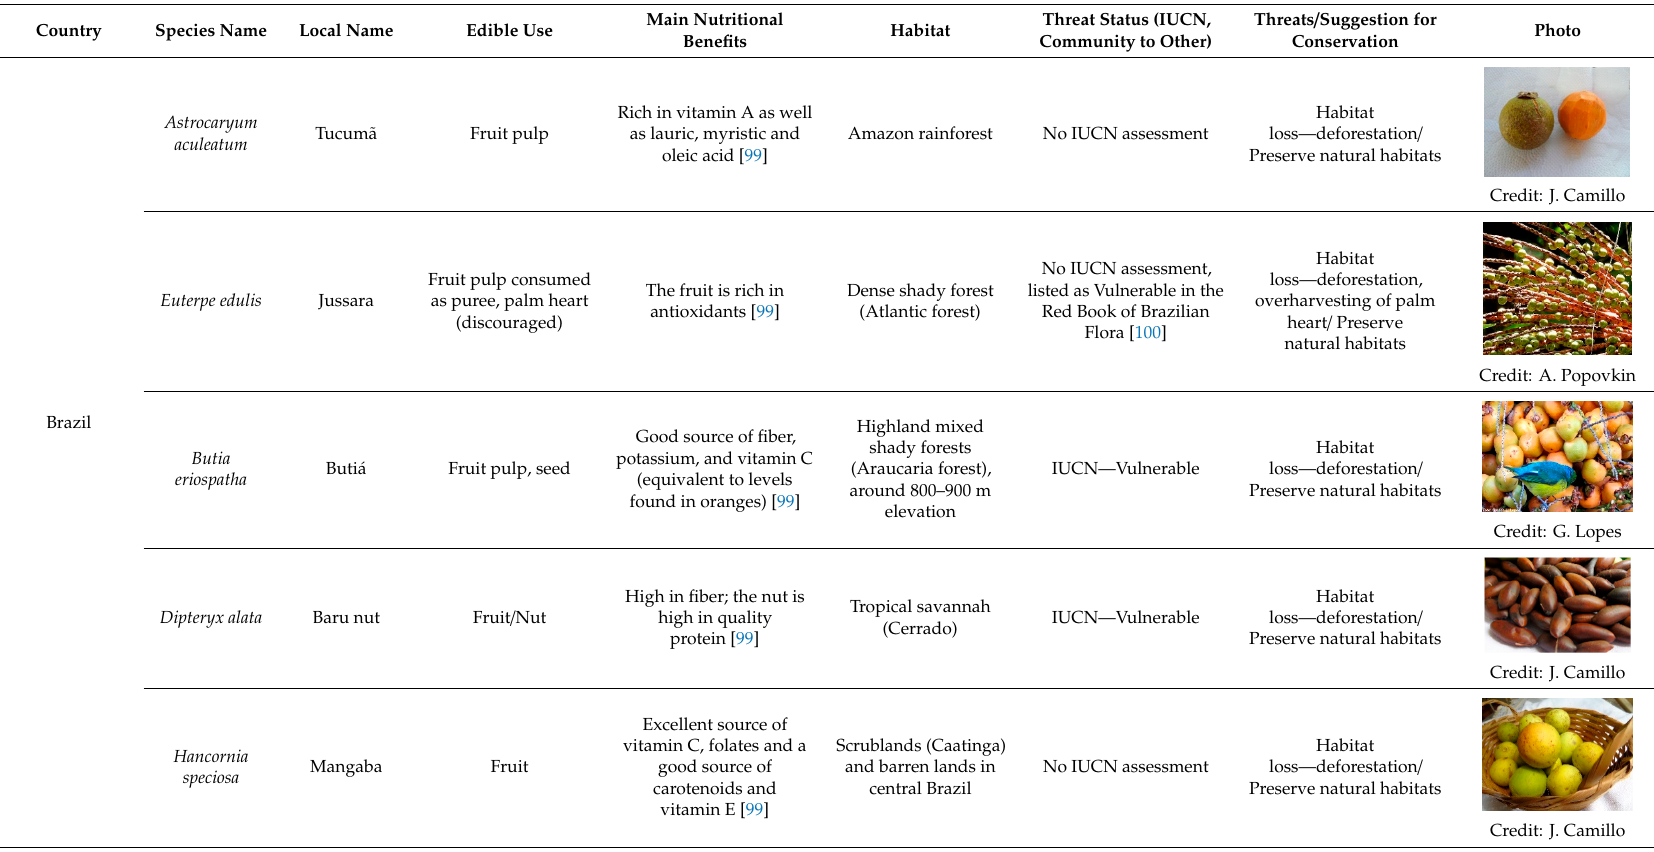
Table 1. Local threat assessments carried out in partnership with local communities have identified increasing dangers to the survival of nutritious and locally important WFPs. A selection from the authors’ project sites is provided along with suggested measures for conservation and sustainable use.